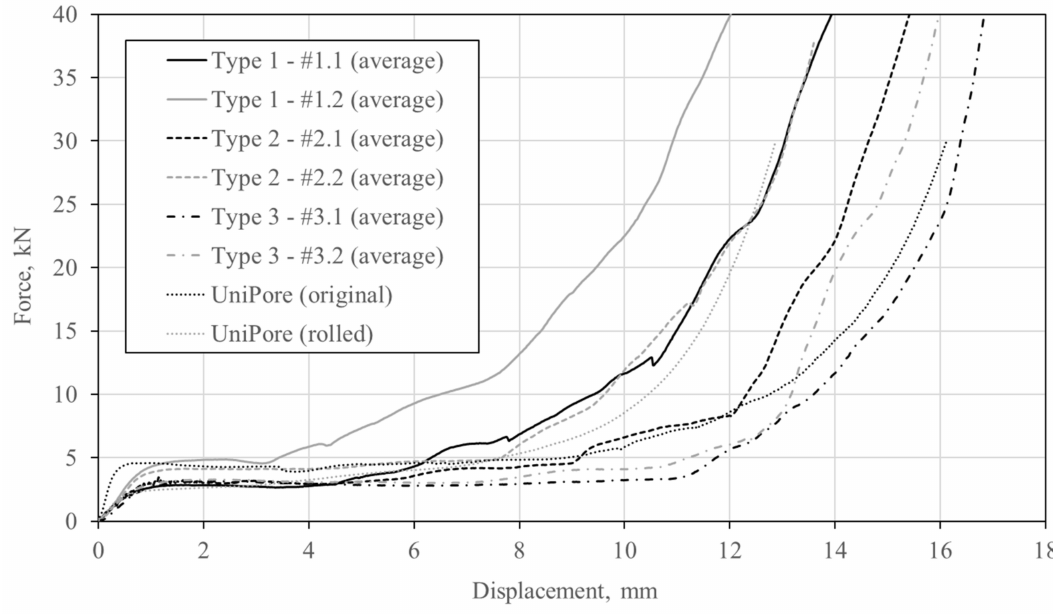
Figure 14. Comparison of compressive responses.